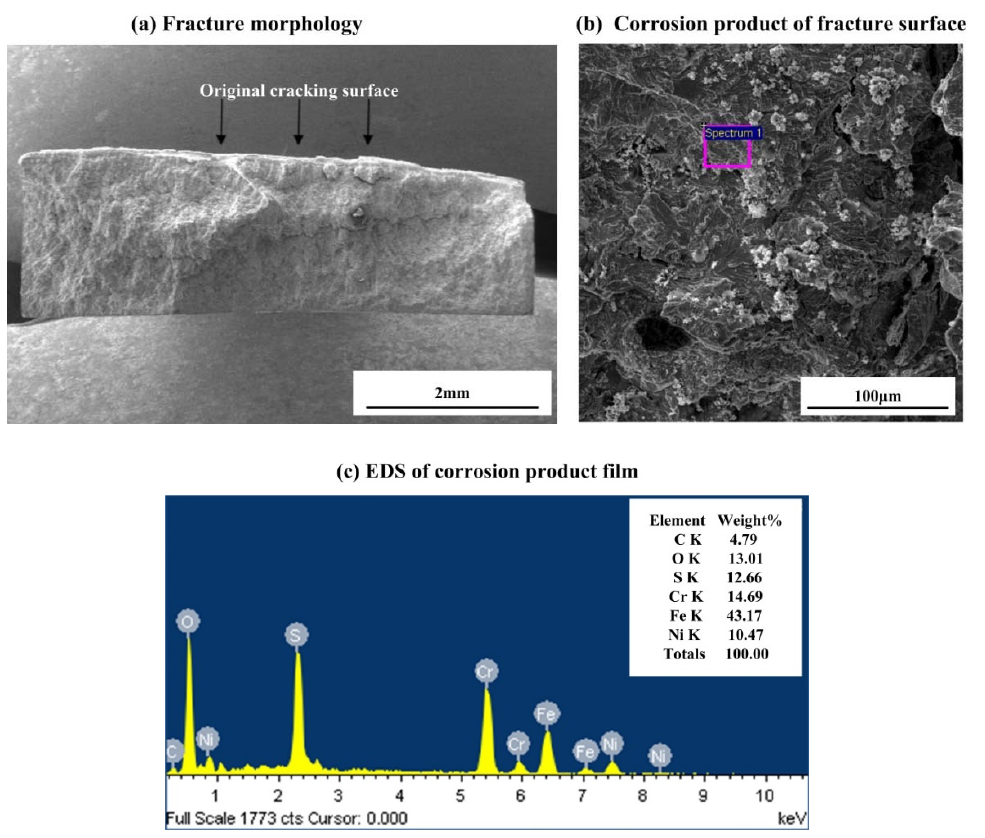
Figure 7. ( a ) Low and ( b ) high magnification of the fracture morphology, and its ( c ) EDS analysis.